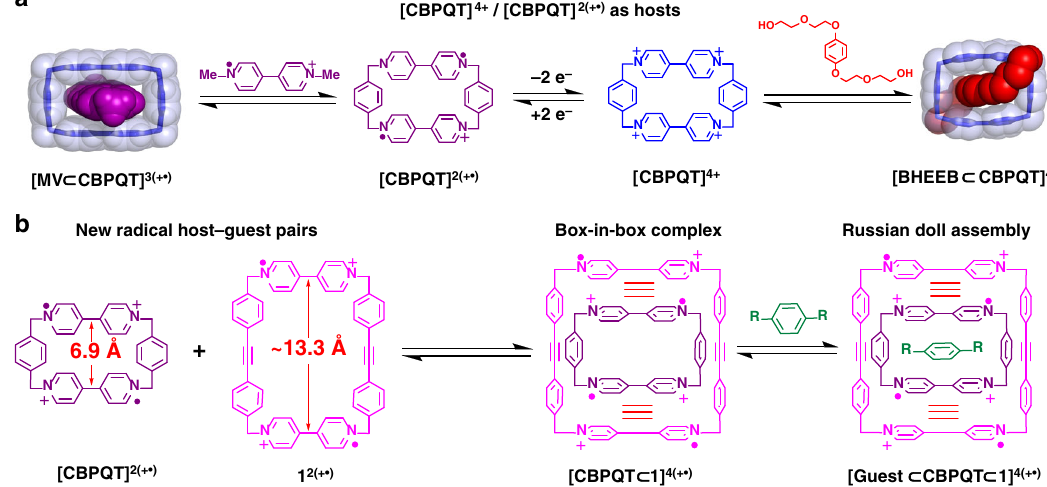
Fig. 1 Design and structures. a Examples of CBPQT 4 + and CBPQT 2( + (cid:129) ) as hosts. b Proposed superstructures of the tetraradical tetracationic box-in-box complex and Russian doll